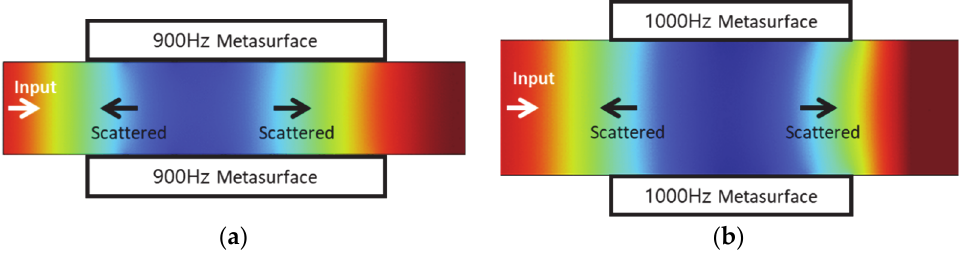
Figure 12. Scattered field at metasurface: ( a ) 900 Hz; ( b ) 1000 Hz.